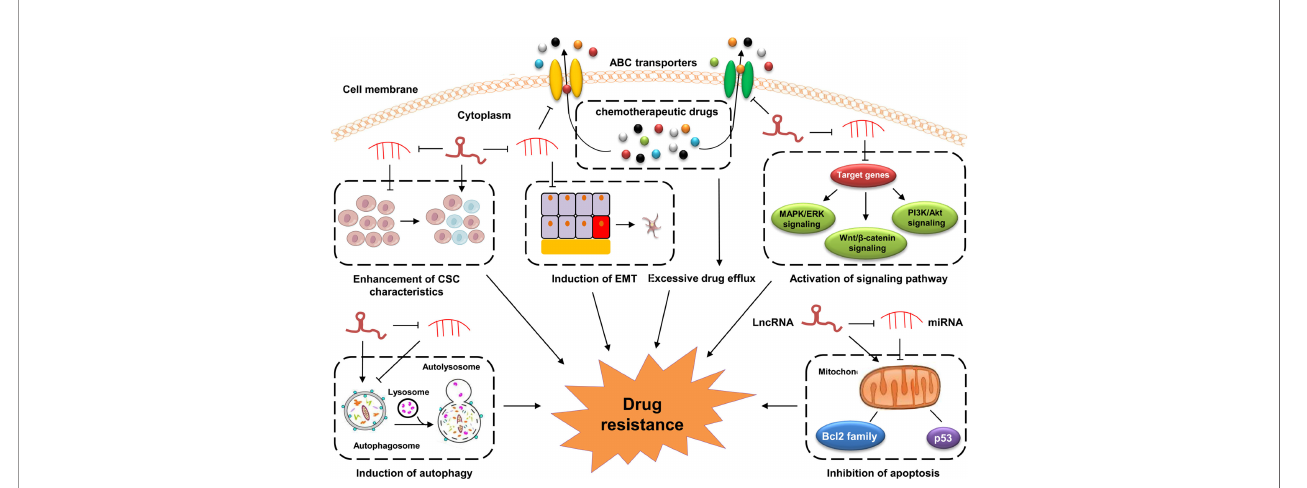
FIGURE 1 | Mechanisms of lncRNAs in GC drug resistance. Dysregulated lncRNAs are involved in GC drug resistance by directly binding to related proteins or sponging miRNAs to altering the expression of downstream target genes involved in cell apoptosis, drug ef fl ux system, EMT, CSCs and drug resistance-related signaling